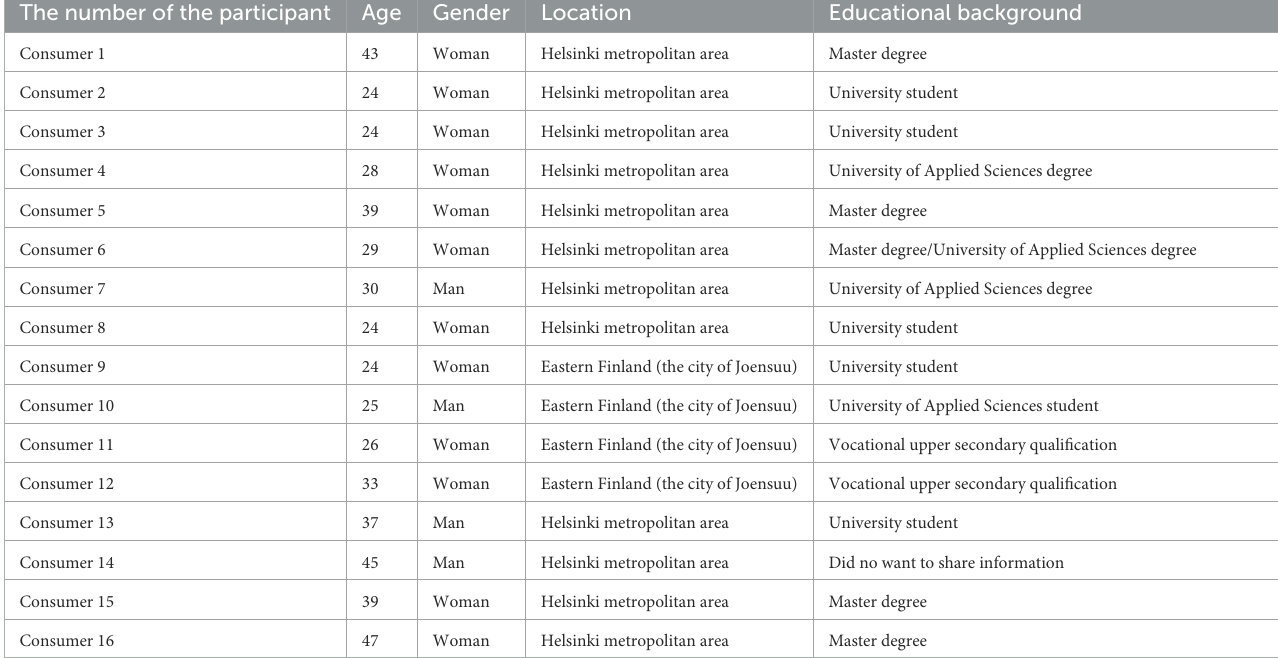
TABLE 1 Background information of the participants: age, gender, place of residence, and educational background. The number of the